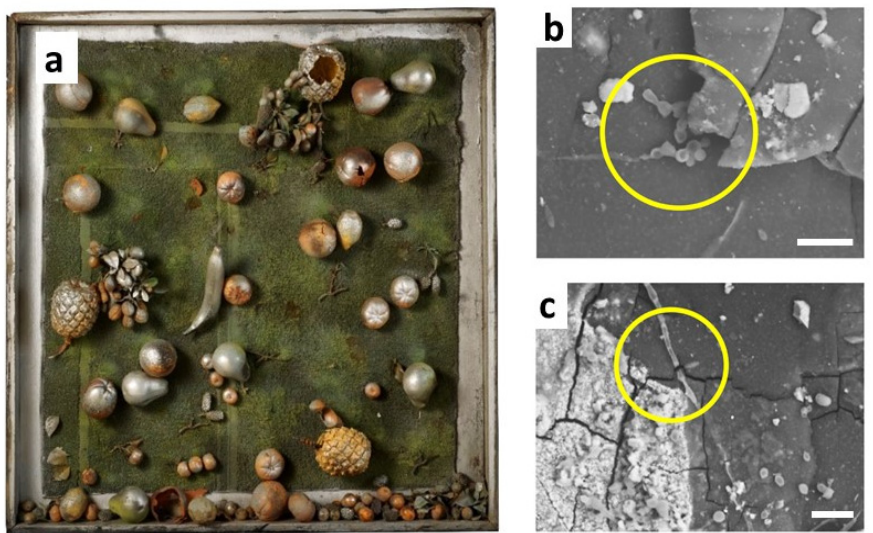
Figure 9. “Teca con frutta” (1967) by M. Zuppelli ( a ) and SEM images of samples from the surface of PE fruits ( b , c ). Scale bar 20 mm. Yellow circles highlight the presence of hyphae and spores. Image reprinted with permission from [61].